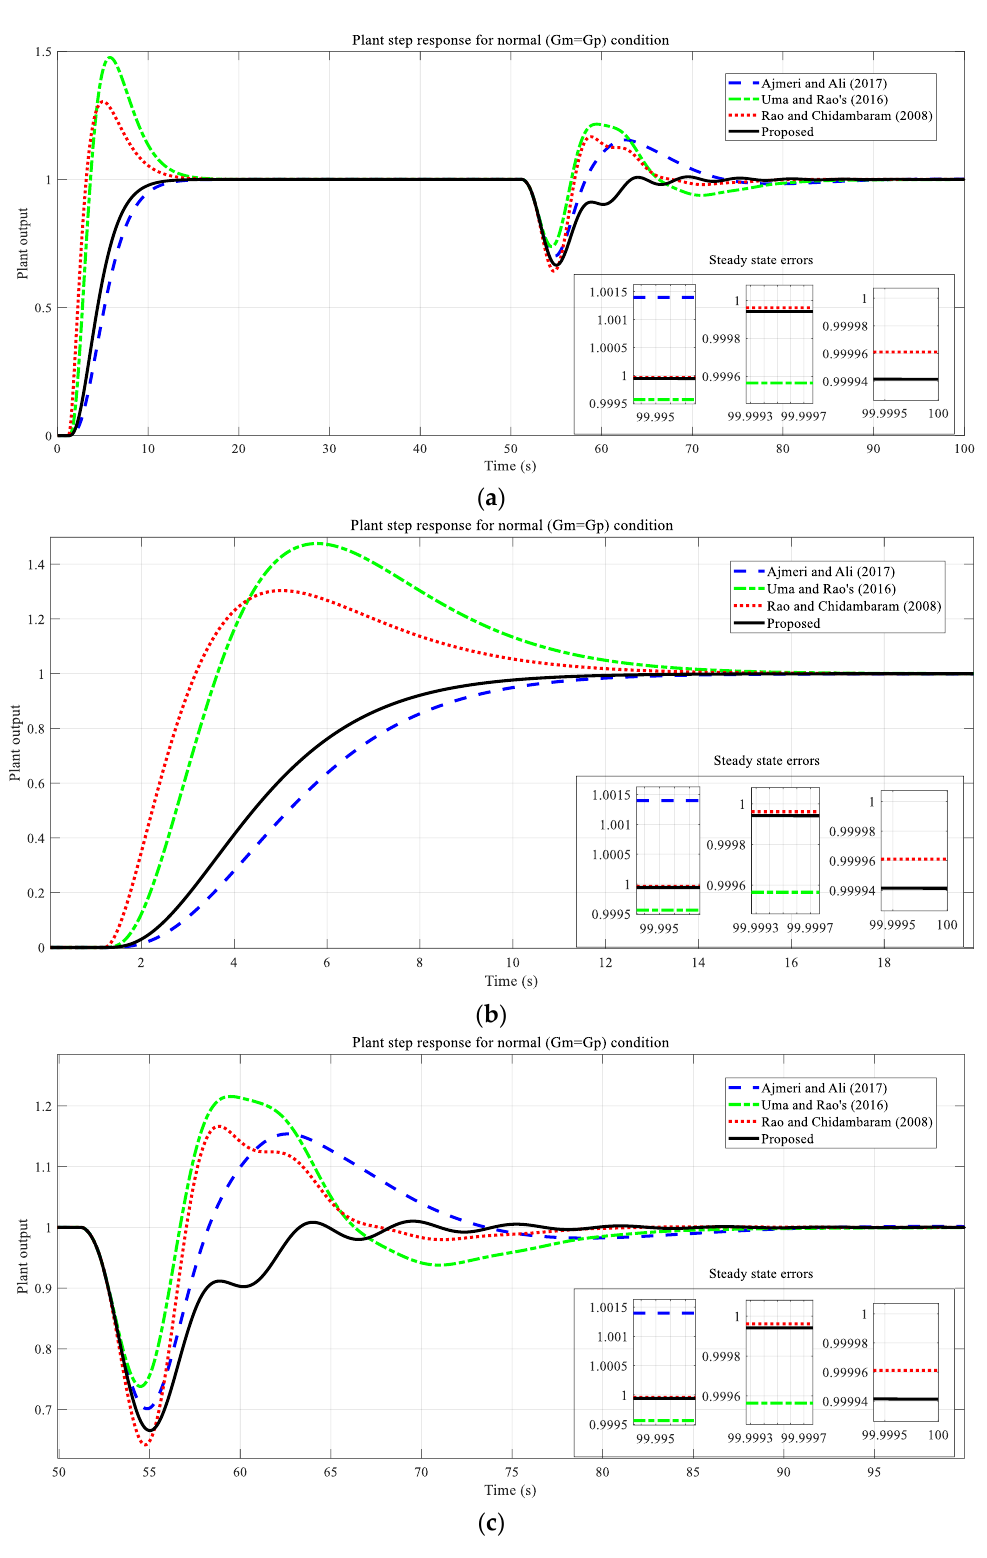
Figure 9. Closed loop performances of the proposed method and other methods for Example 2. ( a ) Set-point tracking and disturbance rejection, ( b ) magnified set-point tracking, and ( c ) magnified disturbance rejection [15,16,18].